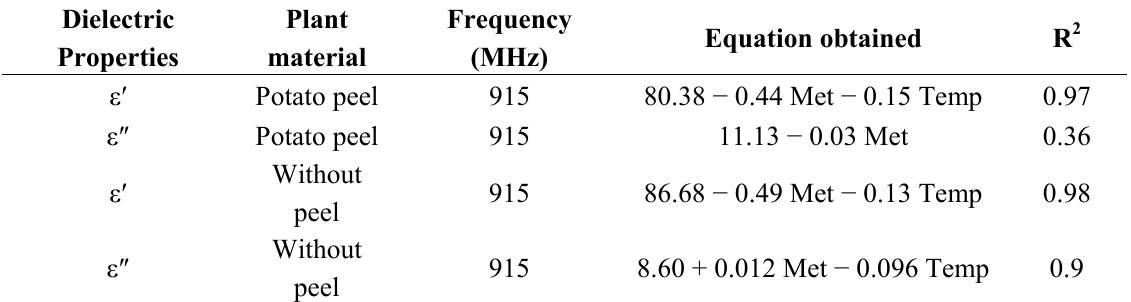
Table 2. Equations defining the relationship between ε′ and ε″ with temperature and methanol fraction concentration at 915 MHz (Source: Adapted from [9]).